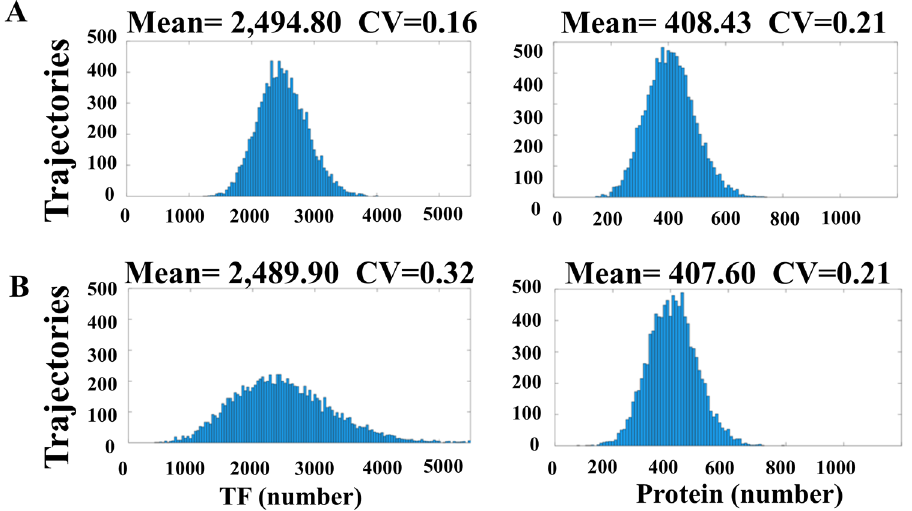
Figure 3. The noise propagation in the FM system. The x-axis is the expression level of TF B (left panels) or downstream protein (right panels). The y-axis is the number of trajectories (cells) having the TF B or protein level indicated by the x-axis. In the FM system, the noise of TF has little effect on the distribution of the downstream protein. Both ( A ) narrow distribution and ( B ) broad distribution of TF lead to almost the same distribution at the protein